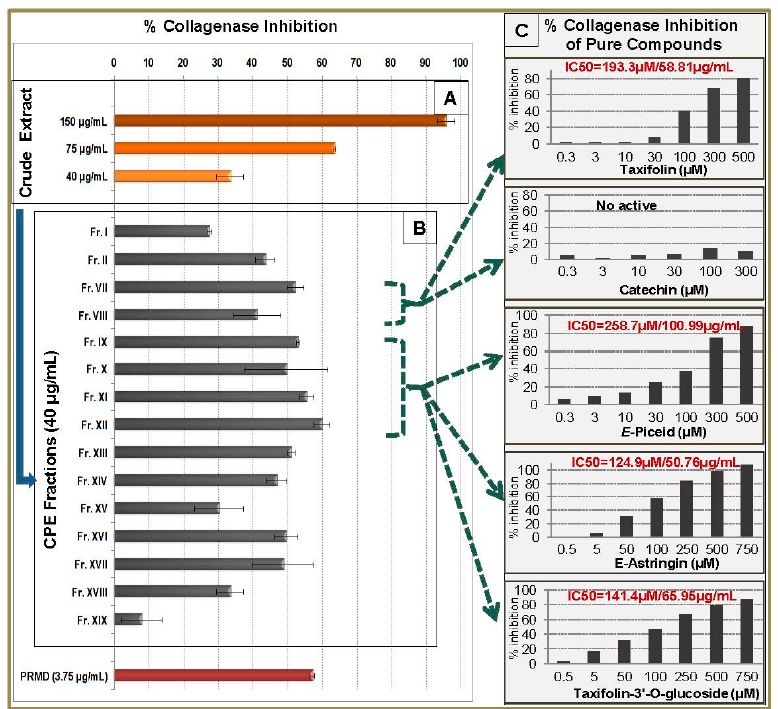
Figure 5. Collagenase inhibitory activity of methanol bark extract, CPC fractions and pure compounds. ( A ) % inhibition activity of crude extract at 150, 75 and 40 μ g/mL, ( B ) % inhibition activity of CPC fractions at 40 μ g/mL and ( C ) % inhibition activity and IC50 value of pure taxifolin, catechin, E -piceid, E -astringin and taxifolin-3 ′ - O -glucoside . Positive control: Phosphoramidon (PRMD) at 3.75 μ g/mL.